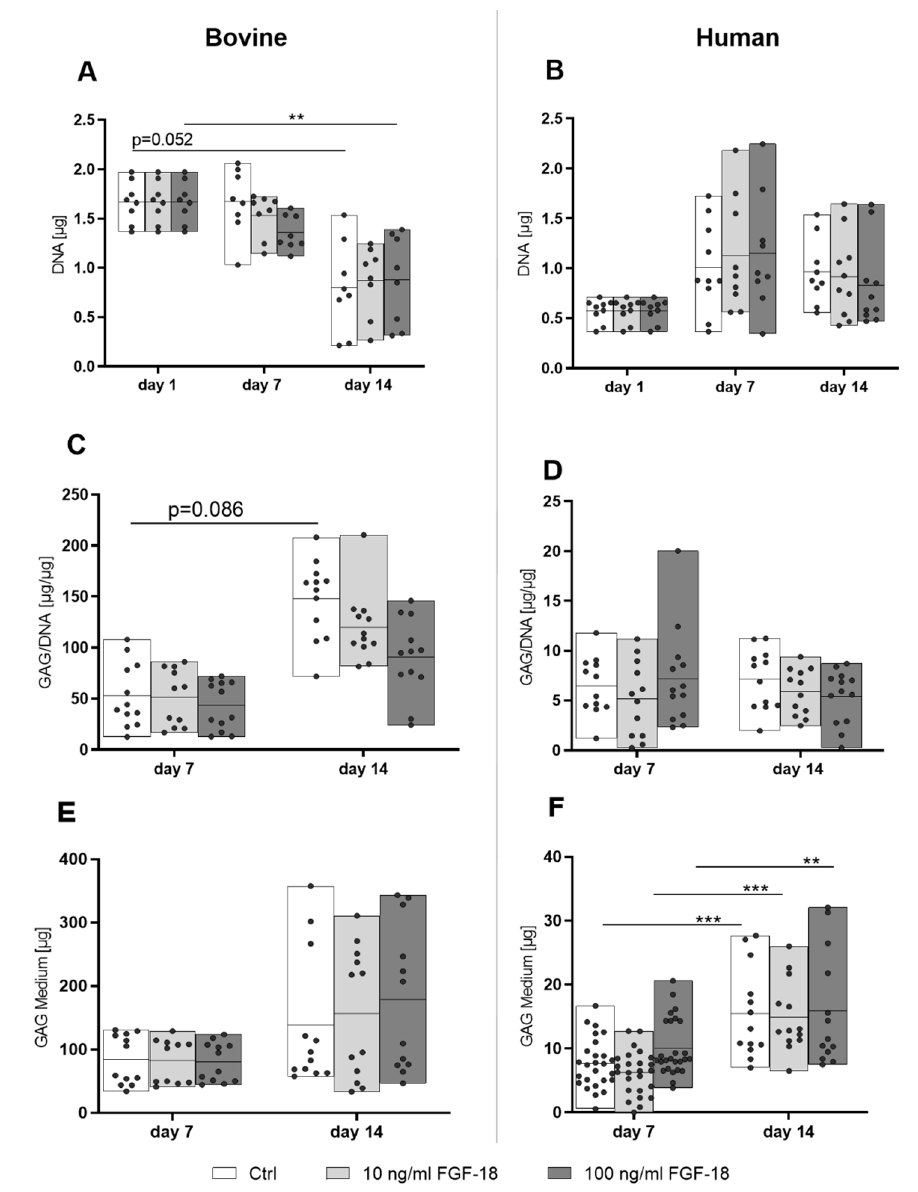
Figure 4. DNA ( A , B ), glycosaminoglycan (GAG) / DNA in hydrogel ( C , D ), and GAG content in medium ( E , F ) for healthy bovine nucleus pulposus cells ( A , C , E ) and mildly degenerated human nucleus pulposus cells ( B , D , F ) encapsulated in FBG-HA hydrogel and stimulated with 10 or 100 ng / mL FGF-18 after 7 or 14 days of culture. n = 4, ** p < 0.01, *** p < 0.001.